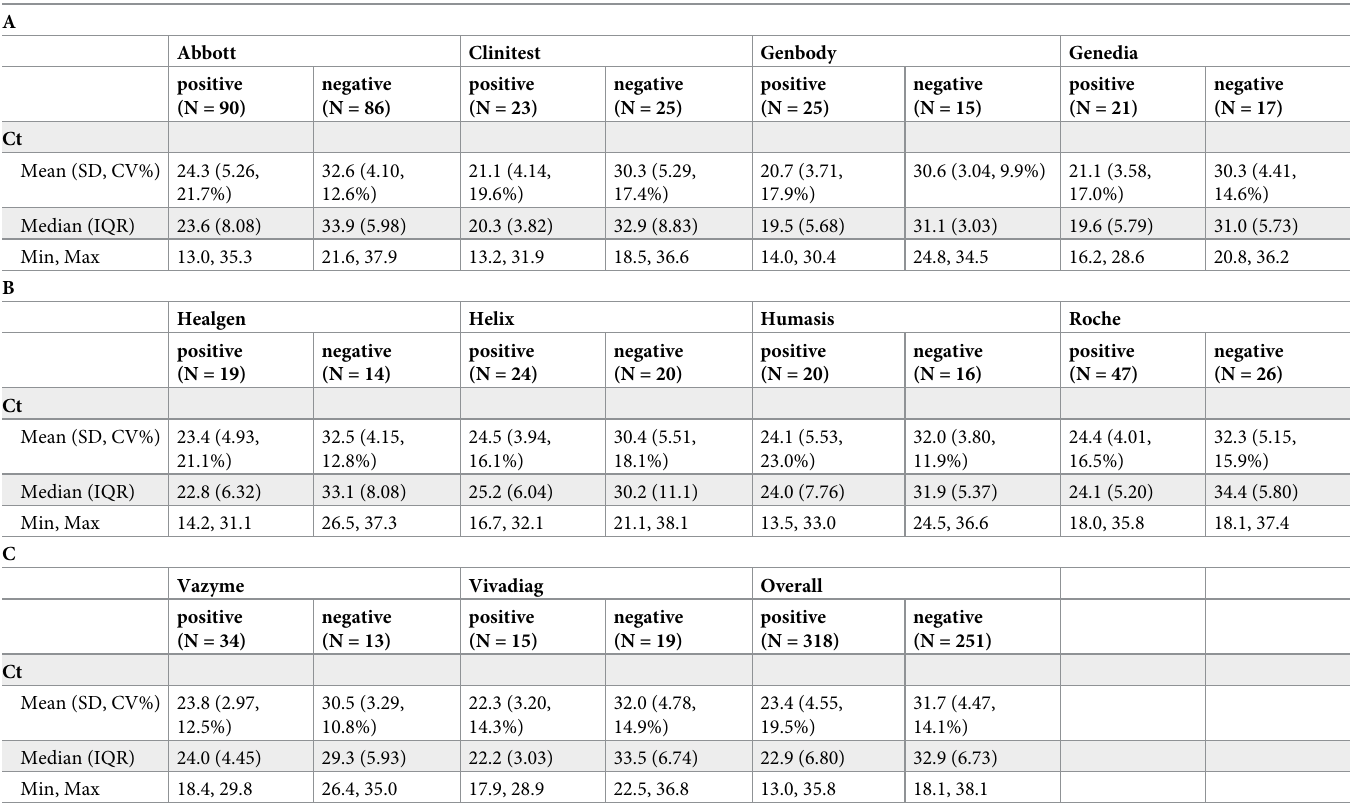
Fig 3. Ct values among true positive (both Ag-RTD and RT-qPCR positive) and false Ag-RTD negative (Ag-RTD negative but RT-qPCR positive) samples by Ag-RTDs. https://doi.org/10.1371/journal.pone.0262399.g003 Table 3. Mean, median, minimum, and maximum Ct values with 95% CI observed in the case of each